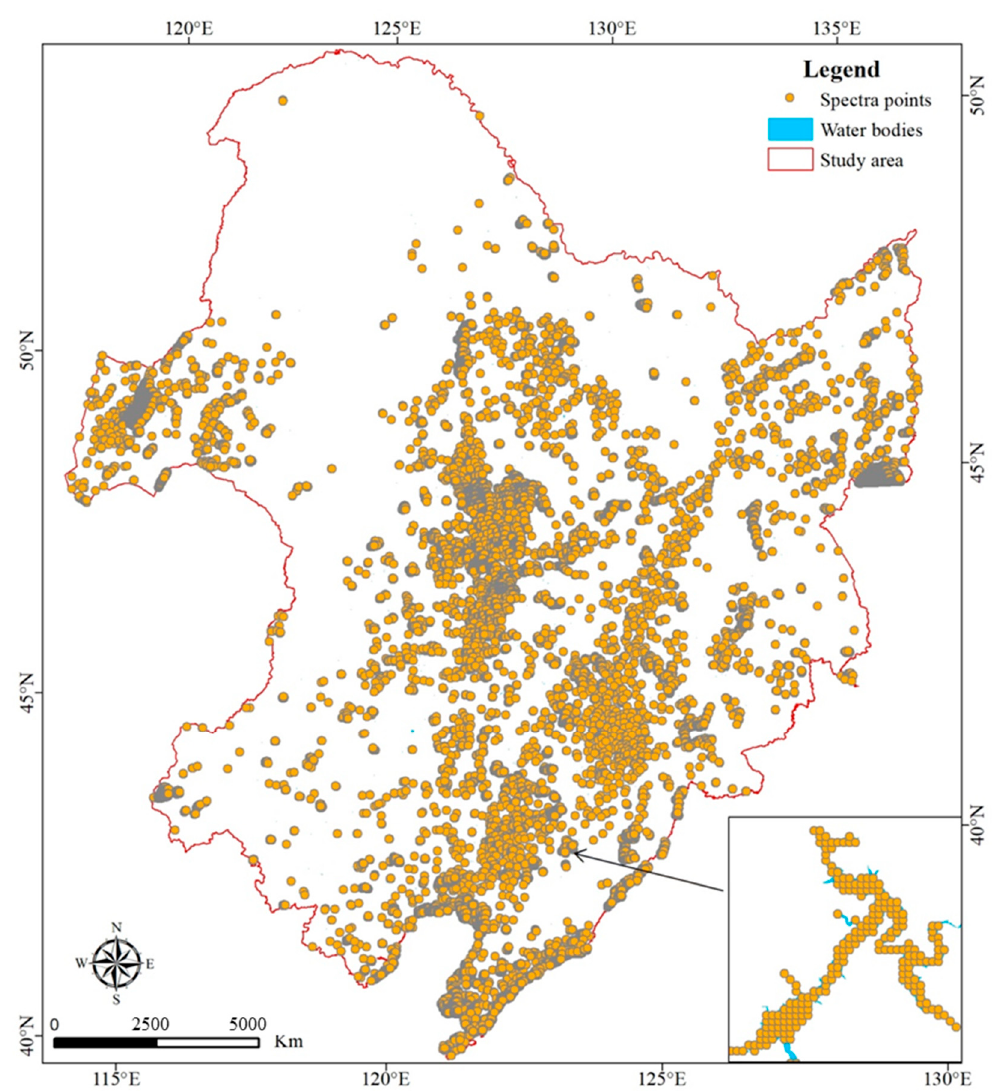
Figure 2. Distribution of spectra sampling points in the study area generated by 500 m × 500 m grids.